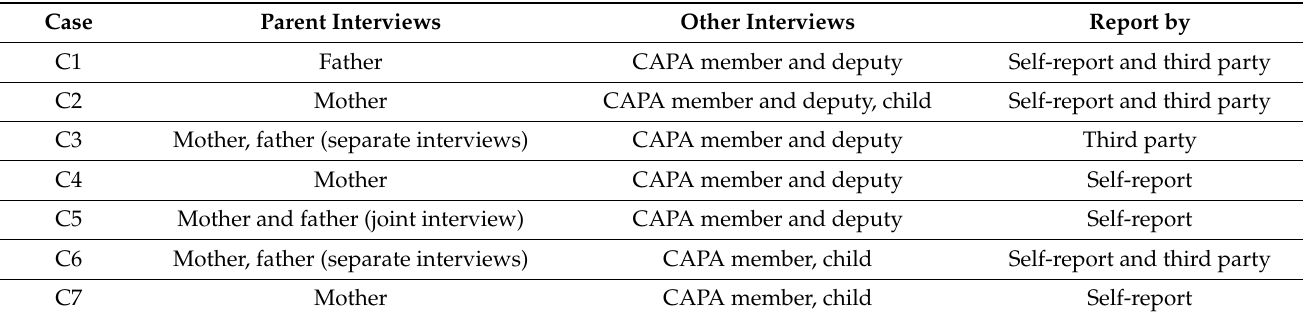
Table 1. Data sample